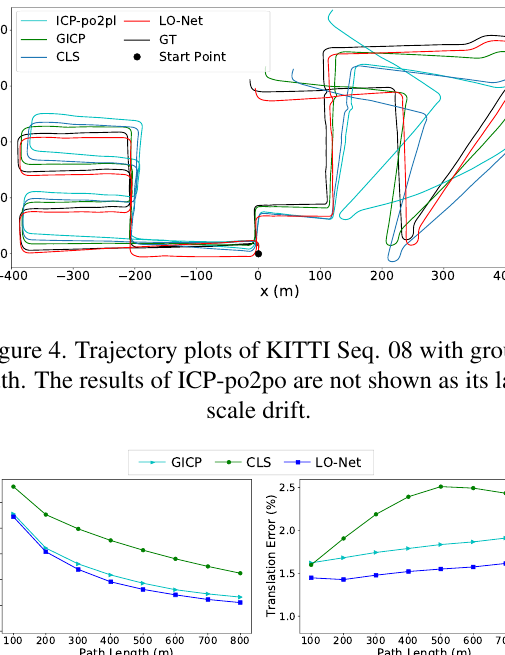
Figure 5. Evaluation results on the KITTI Seq. 00-10. We show the average errors of translation and rotation with respect to path length intervals. LO-Net achieves the best performance among all evaluated methods. The results of ICP-po2po and ICP-po2pl are not shown as its large